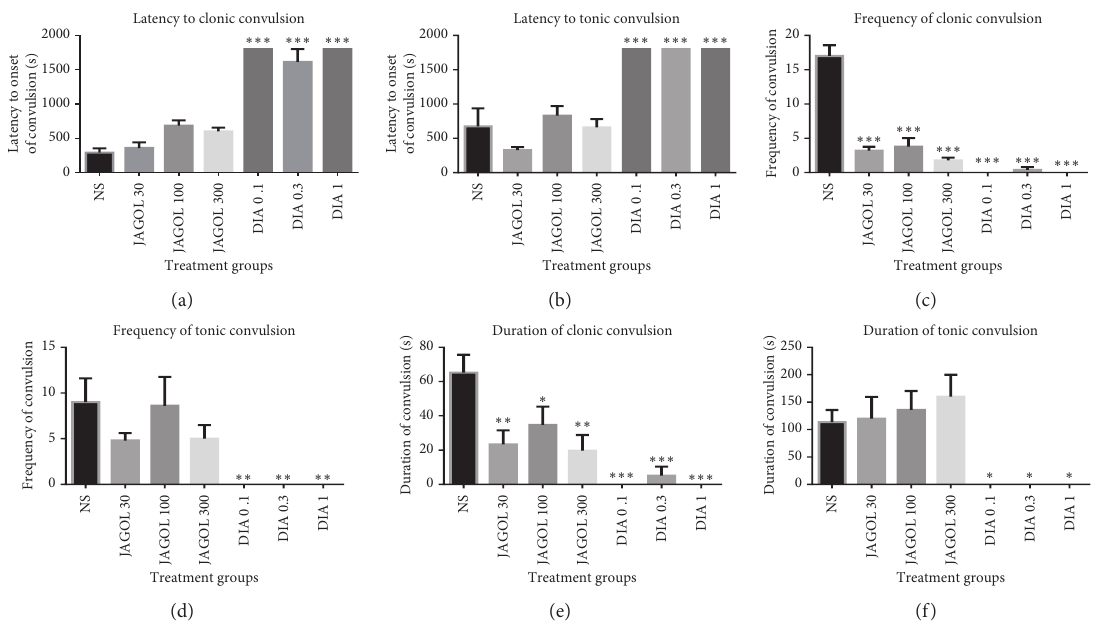
Figure 1: Effect of JAGOL (30–300 mg/kg, p.o .) and diazepam (0.1–1.0mg/kg, i.p .) on the latency to PTX-induced (a) myoclonic and (b) tonic convulsions, frequency of (c) myoclonic and (d) tonic convulsions, and duration of (e) myoclonic and (f) tonic convulsions. Each column represents the mean ± SEM ( n � 5). ∗∗∗ P < 0 . 001, ∗∗ P < 0 . 01, and ∗ P < 0 . 05, one-way ANOVA followed by Bonferroni’s multiple comparison test. JAGOL: Jatropha gossypifolia leaf extract; DIA: diazepam.